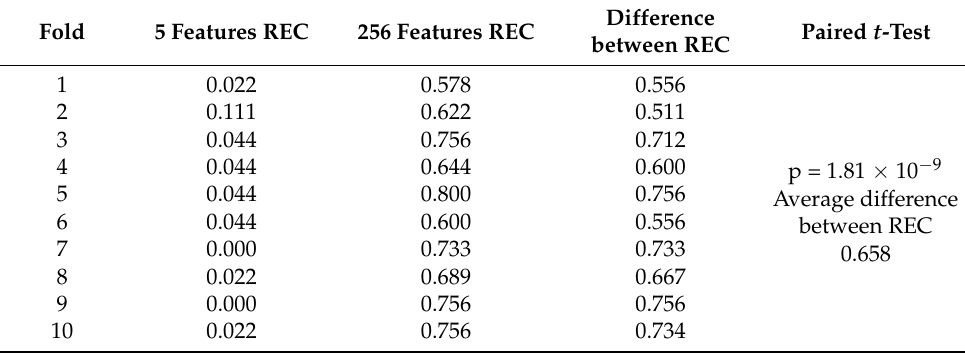
Table 6. Paired t -test of recall for 5 Features vs. 256 Features.